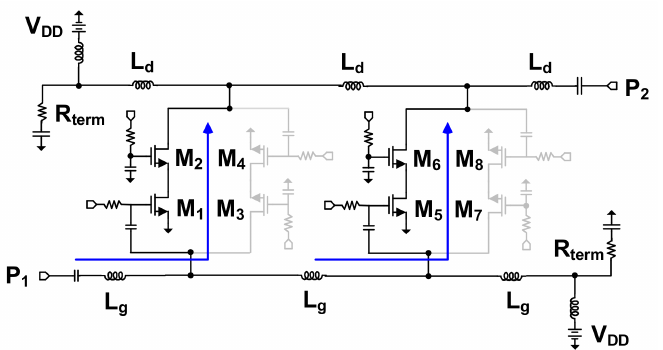
Figure 7. Schematic of the switchless bi-directional amplifier (operation mode: P 1 ->P 2